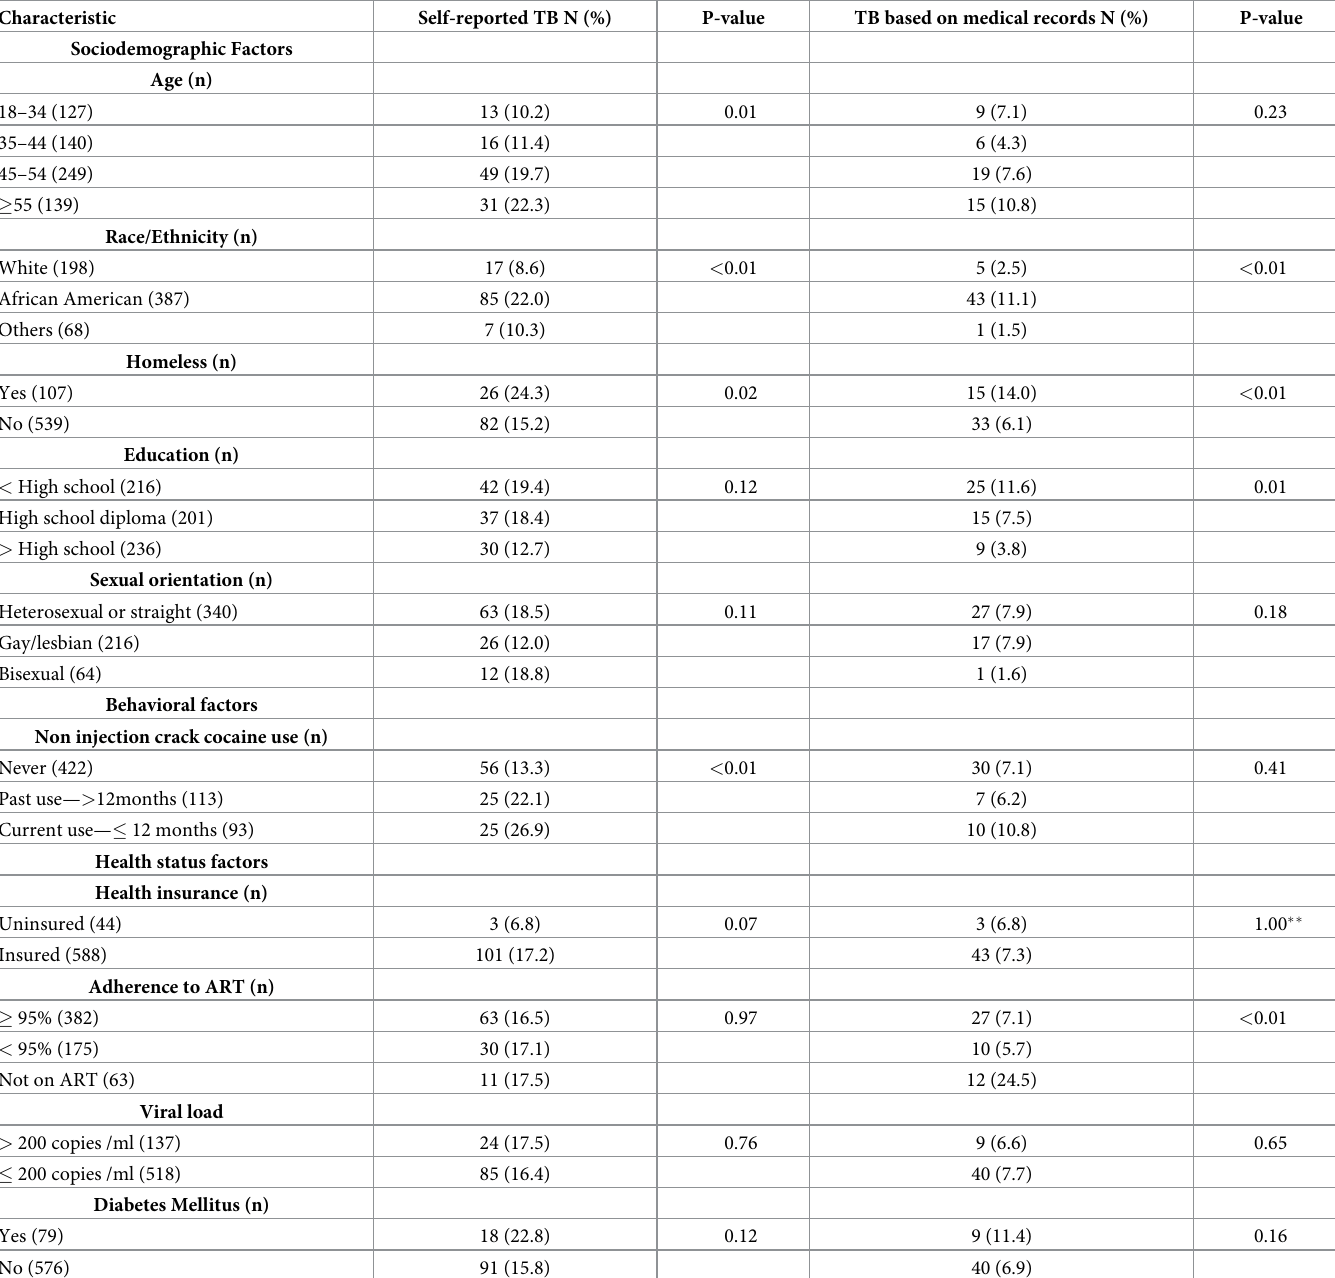
Table 2. Factors associated with TB according to self-reports and medical records among 655 persons living with HIV in Florida.